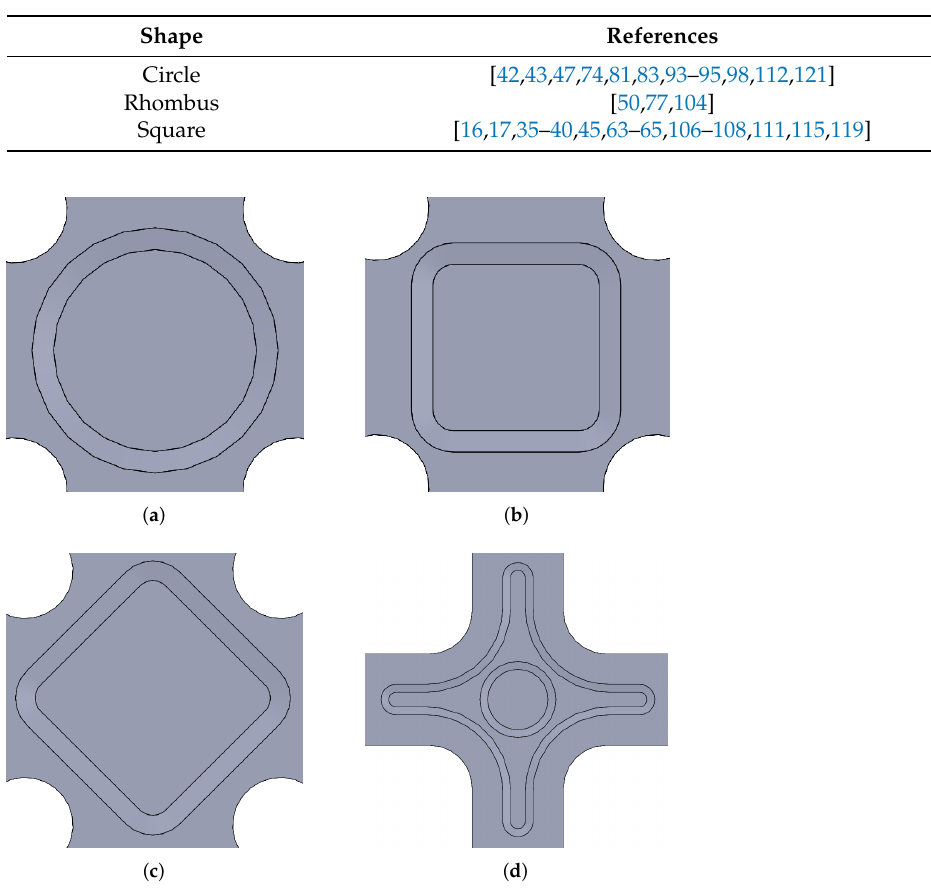
Table 2. Preferred shape for central gauge zone in experimental biaxial tests with FRP composites.